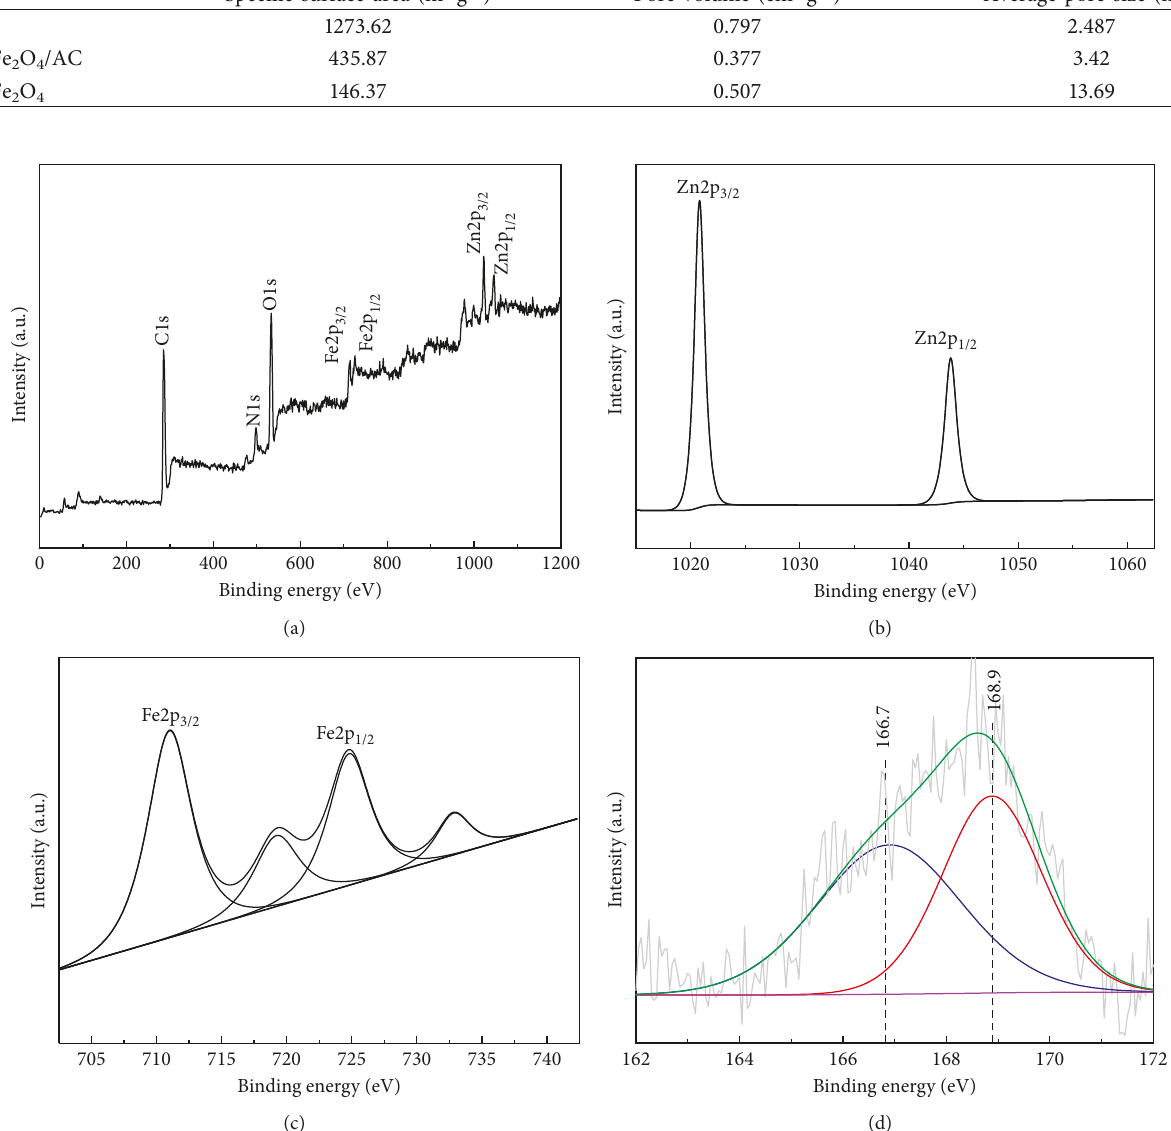
Figure 11: XPS spectrum of the ZnFe 2 O 4 /AC composite: (a) the score of the composite; (b) fitting of Zn2p peak; (c) fitting of Fe2p peak; (d) fitting of S2p